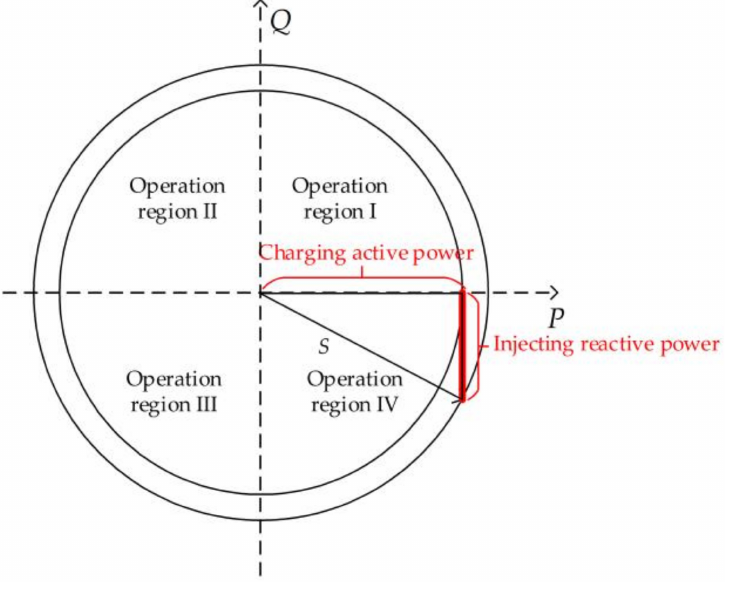
Figure 2. Operation region of EVs